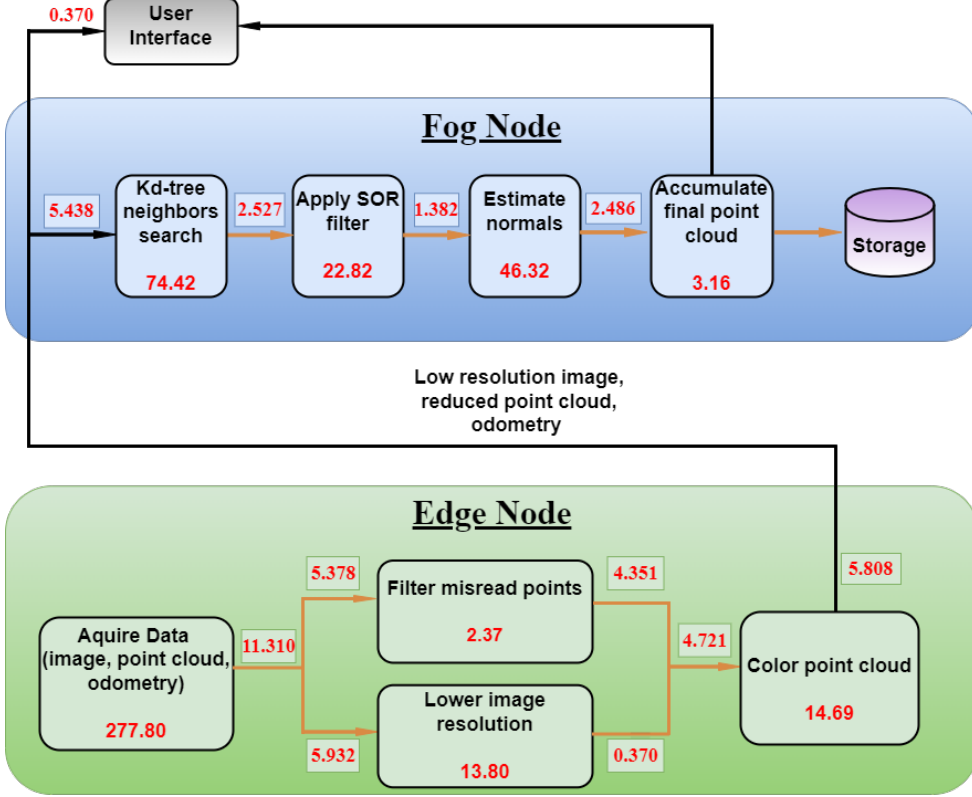
Figure 4. Logical processing workflow split into edge and Fog Nodes. Numbers inside the boxes indicate the processing PU ( × 10 5 ). Numbers in the arrows indicate the average message sizes in MB. All data should refer to Table